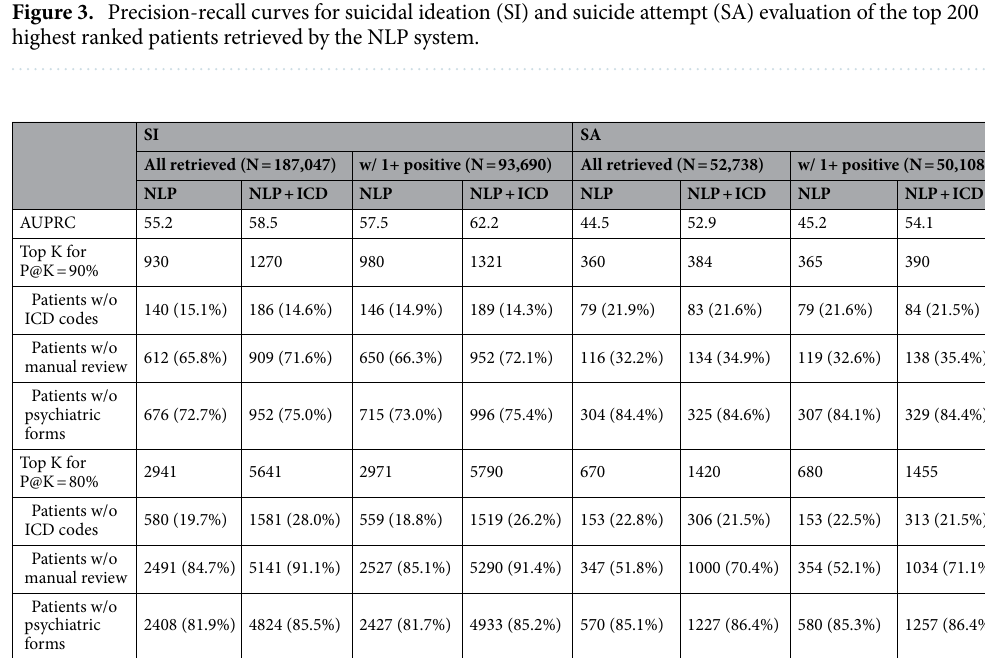
Table 3. Evaluation of label assignment methods for suicidal ideation (SI) and suicide attempt (SA). The “All retrieved” columns represent results of the methods using the initial lists with all the retrieved patients for SI (N = 187,047) and SA (N = 52,738). The “w/ 1+ positive” columns correspond to methods using only patients with at least one positively asserted suicide mention in their notes. “NLP” and “NLP + ICD” columns are associated with methods using p rank and p NLP + ICD , respectively, for suicide label assignment.